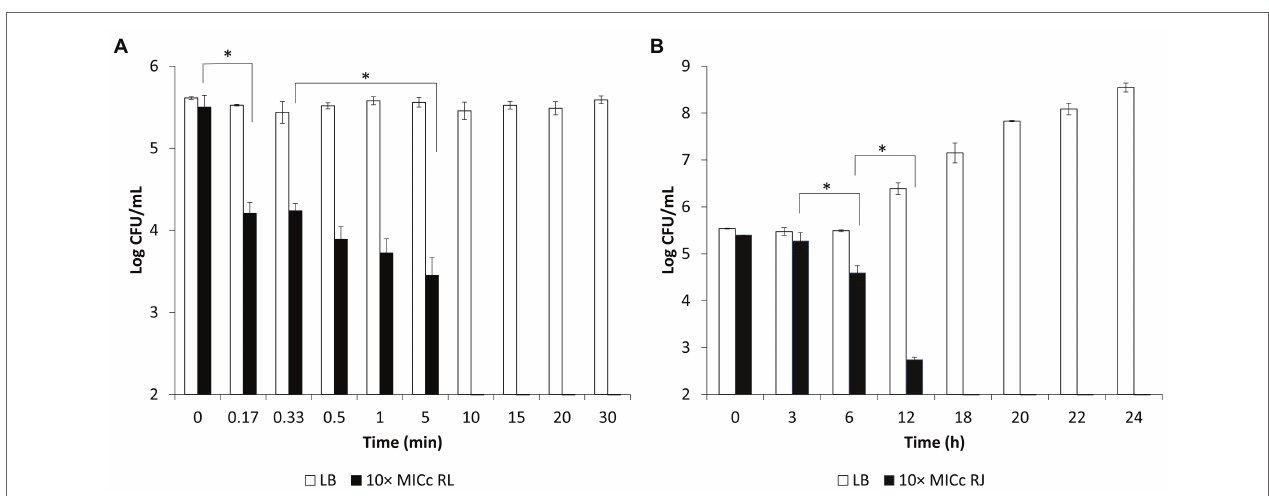
FIGURE 5 | Counts of viable Salmonella mixture ( Salmonella Enteritidis MNHN, Salmonella Heidelberg CMBL4-8, and Salmonella Newport ATCC 6962) after exposure in 10 times minimum inhibitory concentrations in combination (10 × MIC c ) of reuterin + lactic acid (RL; A) and reuterin + microcin J25 (RJ; B) . LB broth as negative control. Bars indicate standard deviation. * p <